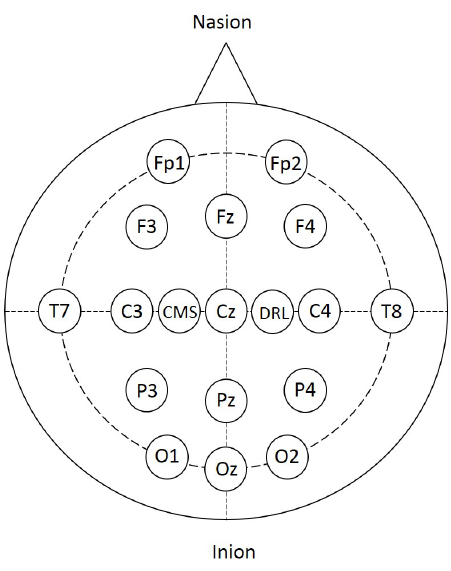
Figure 3. The positions of the EEG electrodes employed in this study arranged according to the 10–20 EEG